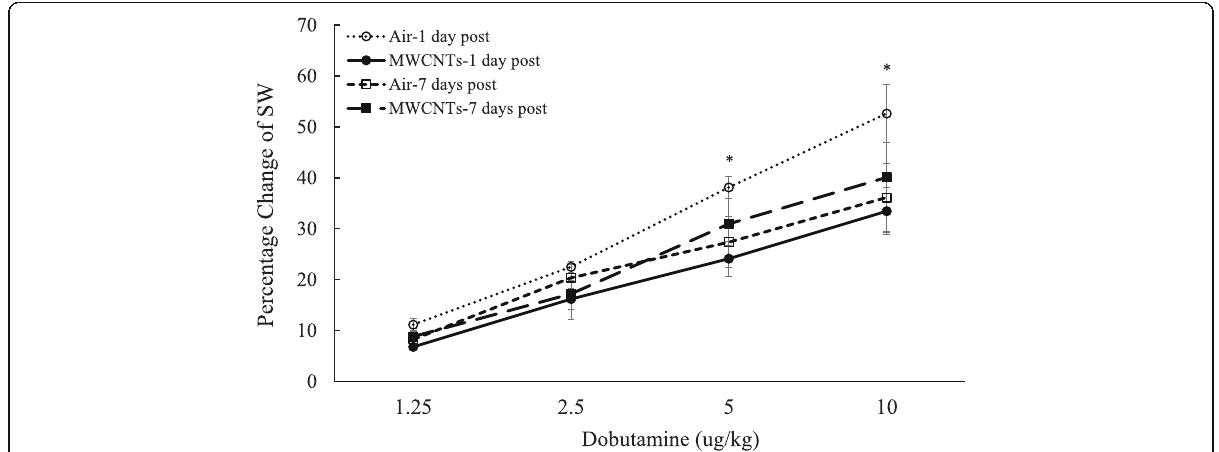
Fig. 4 Line graph depicting a percentage change of stroke work (SW) from the basal level before exposure (pre-exposure control vs MWCNTs at 1 day post: 11276 ± 1165 vs 11,151.7 ± 727.9 mmHg× μ l, control vs MWCNTs at 7 days post: 13245± 893.4 vs 13,644.2 ± 536.5 mmHg× μ l). Each value represents the mean ± SE of eight rats. P < 0.01 exposed compared with control group at 1 day post-exposure